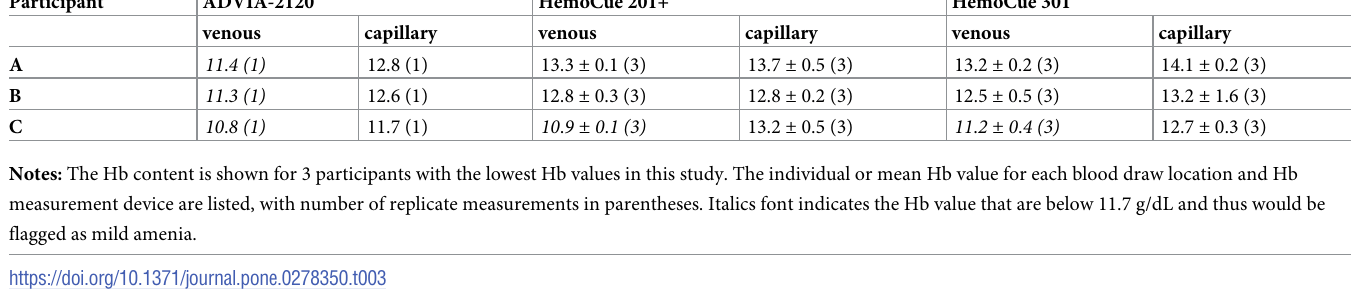
Table 3. Hemoglobin measurements in select participants using values from different blood draw sites and measurement devices.